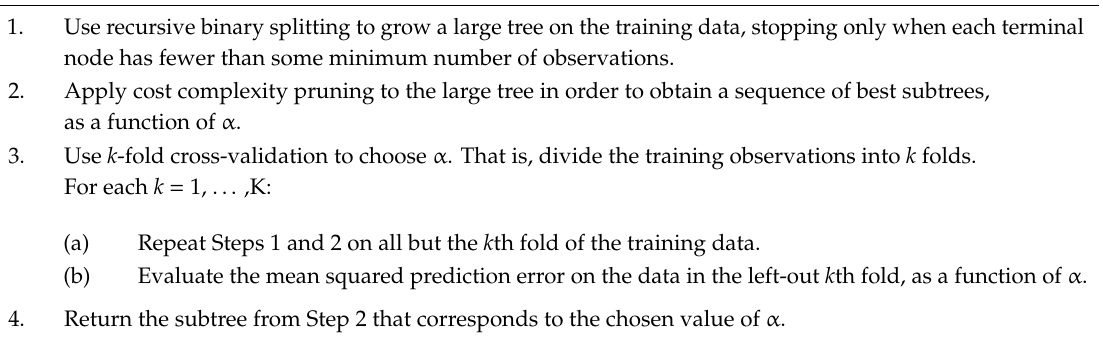
Algorithm 1. Building a Regression Tree